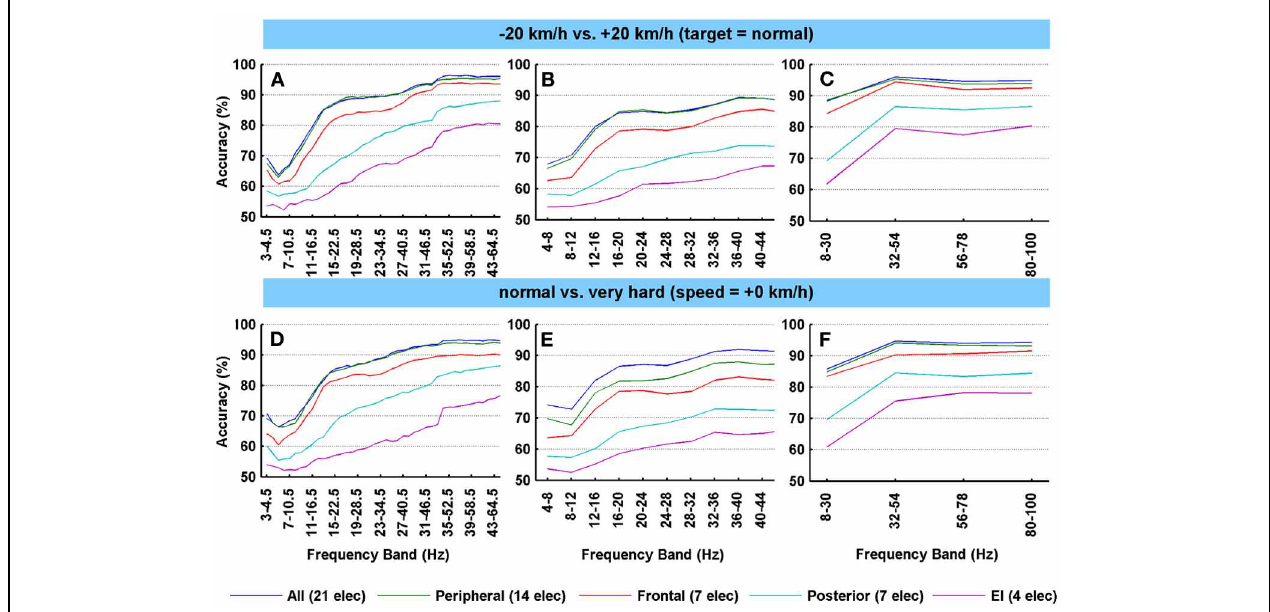
start frequency (step size 1Hz), starting at 3–4.5Hz and ending at 43–64.5 Hz. For the middle column (B,E) , 4Hz bands were used and a stepsize of 4. For the right column (C,F) , a broad band frequency search (22Hz) was deployed. All electrodes: FP1, FP2, Afz, F7, F5, Fz, F4, F8, T7, C5, C3, Cz, C4, T8, P7, P3, Pz, P4, P8, O1, O2. Peripheral set: FP1, FP2, Afz, F7, F5, F4, F8, T7, C5, T8, P7, P8, O1, O2.